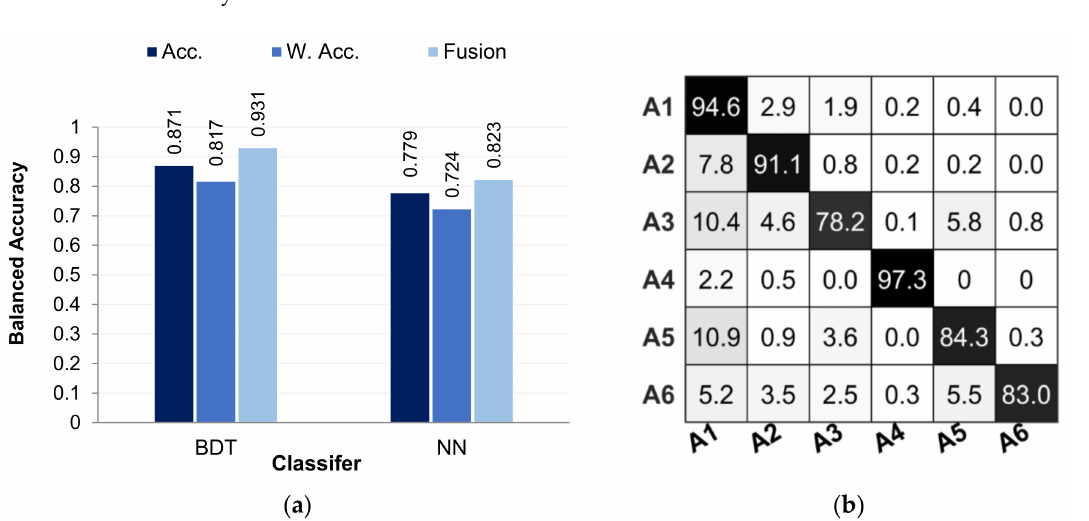
Figure 3. ( a ) Average results attained for PPAR using BDT and NN classifiers; ( b ) Confusion matrix (in percentage form) for the best-case PPAR performance accomplished with BDT using the phone and watch accelerometer combination. The labels A1-A6 represent six activities, i.e., lying, sitting, walking, standing, running, and bicycling,